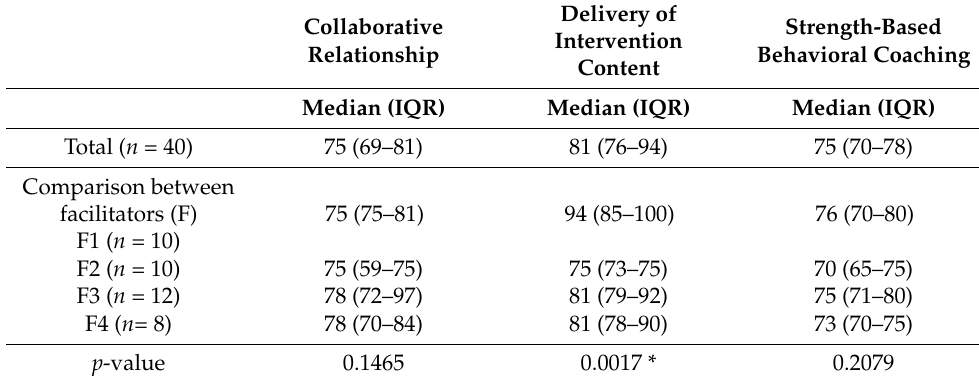
Table 3. Factor score distribution (median and interquartile range *) for the final domains.